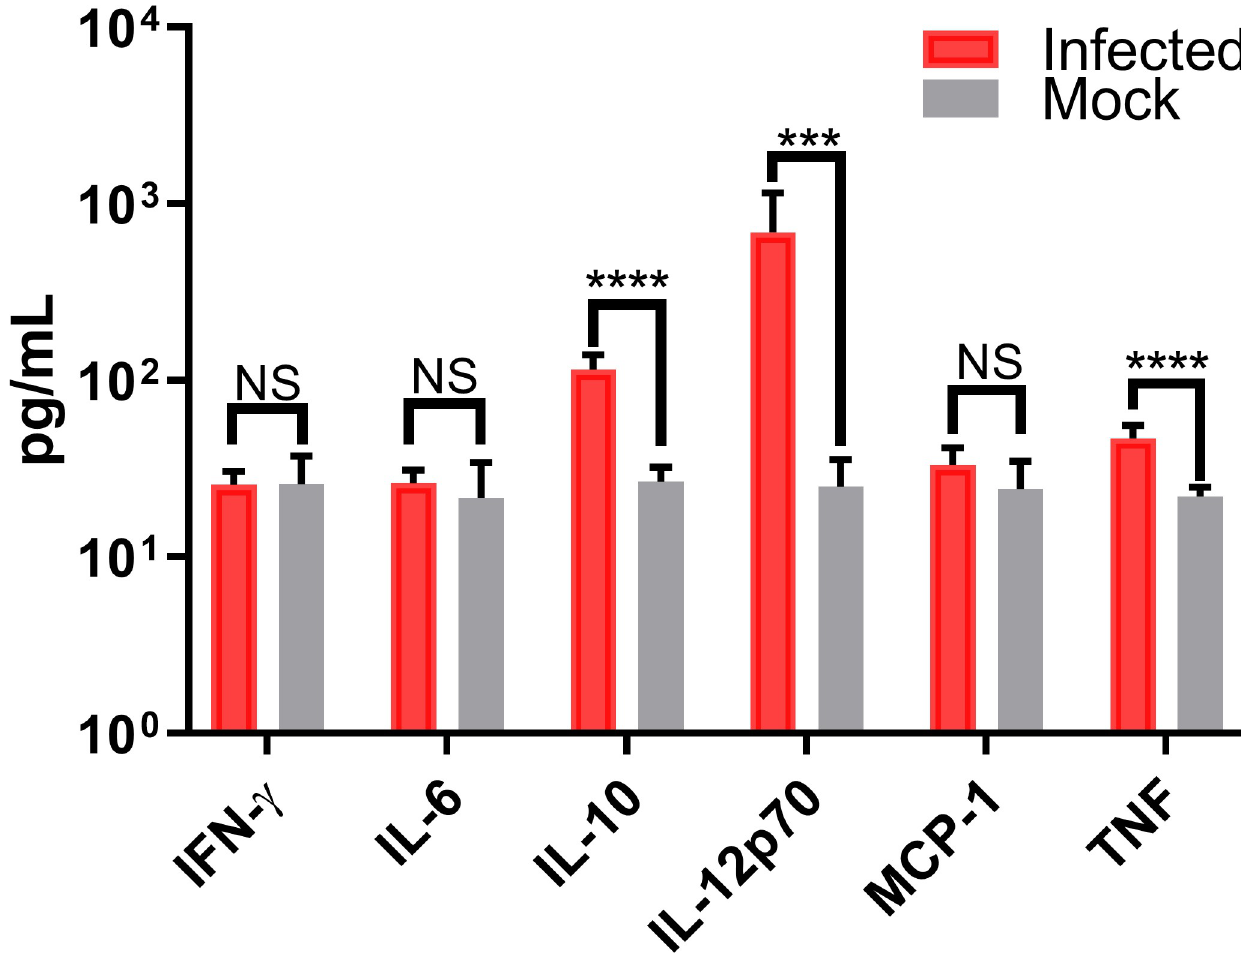
Fig 6. Cytokines induced in CHIKV-infected murine macrophages. Secreted cytokine levels in CHIKV-infected murine RAW264.7 macrophages were quantified 24 hpi using cytometric bead arrays. Data shows mean values of three independent experiments with a total of n = 9, MOI = 5. Statistical significance was determined using multiple t-test corrected using Holm-Sidak method. � P < 0.05; �� P < 0.01; ��� P < 0.001; ���� P < 0.0001; NS, not significant.